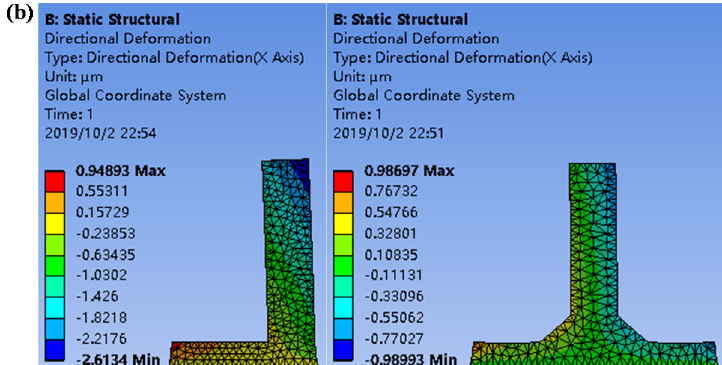
Figure 5. Thermal stability analysis results of the ( a ) original (left) and optimized (right) PBS mounts, and the ( b ) original (left) and optimized (right) FL mounts on the Z axis. Table 2. The angular errors around the Y axis of the fixed mounts.